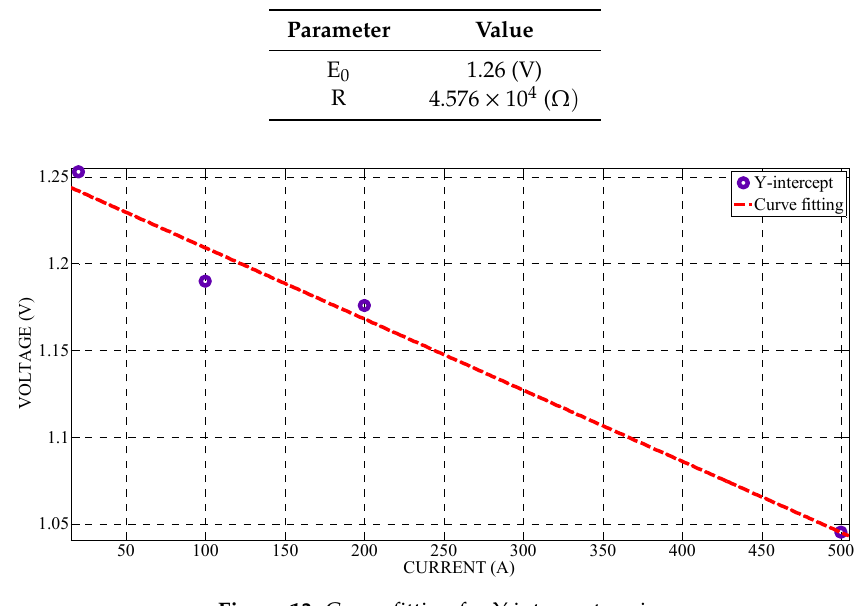
Figure 13. Curve fitting for Y-intercept vs. i.